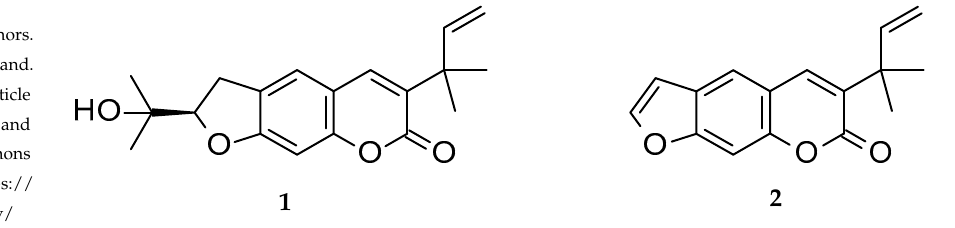
Figure 1. Structures of chalepin ( 1 ) and chalepensin ( 2 ).